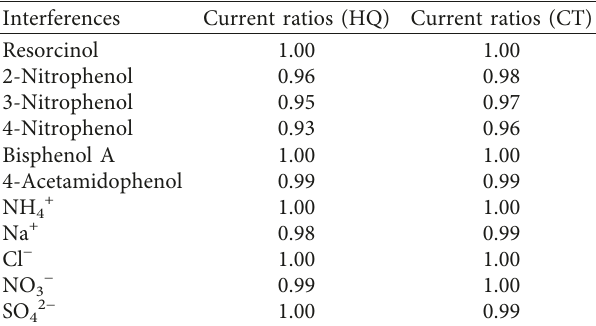
Table 2: Estimation of the oxidation current ratios of HQ and CT in the absence and presence of